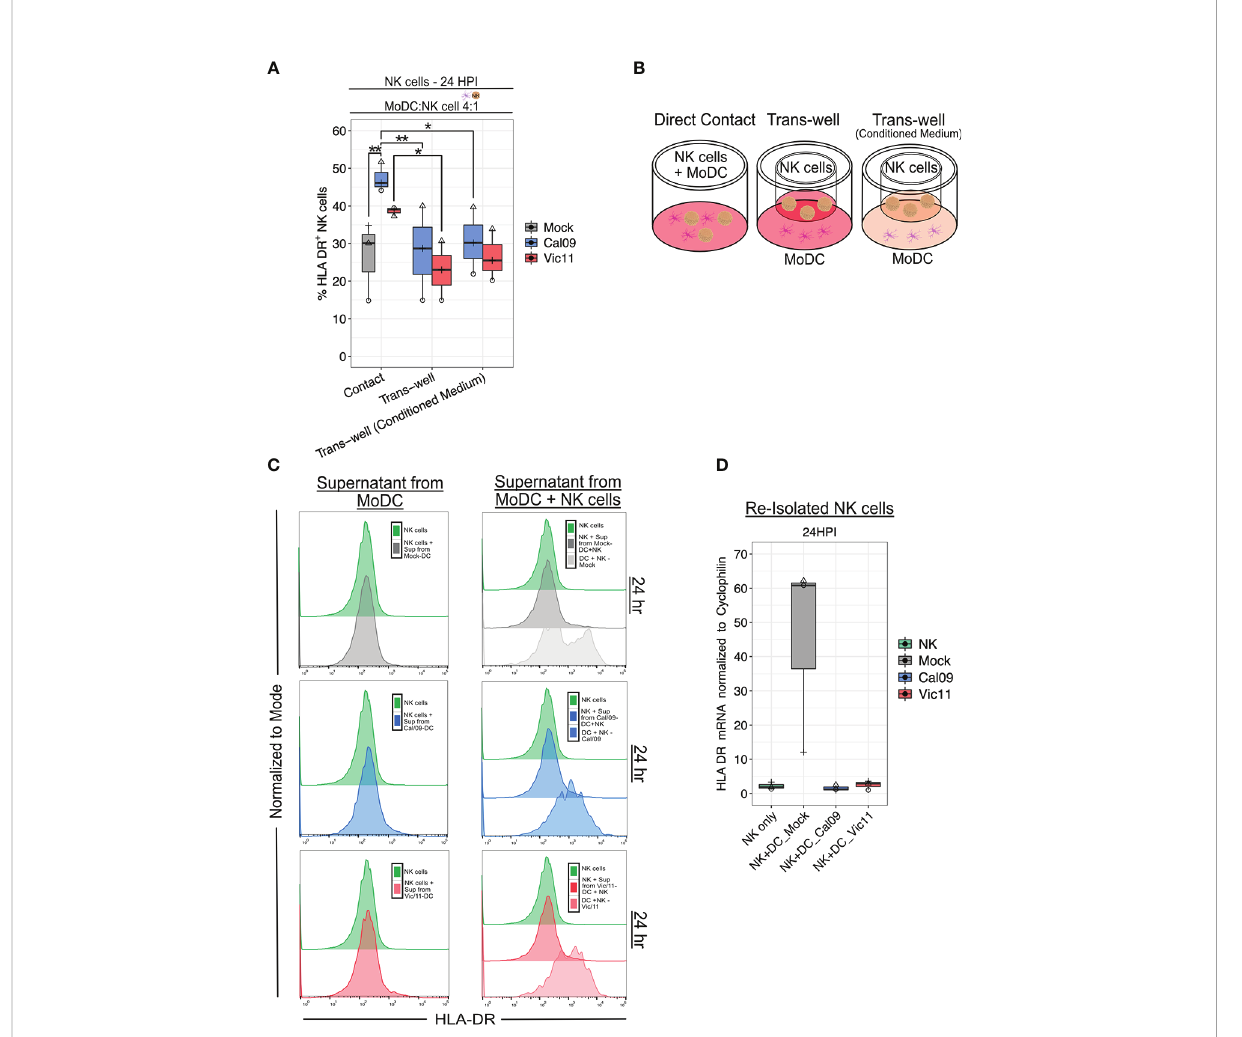
FIGURE 4 Direct contact is required for HLA-DR expression on NK cells after co-culture with IAV-exposed MoDCs. (A) Percentage of HLA-DR + NK cells and HLA-DR MdFI after 23 h co-culture with mock-treated or IAV-exposed MoDCs at an MOI of 3 as assessed by fl ow cytometry using an antibody speci fi c to HLA-DR. MoDCs were cultured in direct contact with NK cells (contact), with MoDCs seeded in the dish and NK cells seeded in the transwell with fresh medium (Trans-well) or with conditioned medium (Trans-well (conditioned medium) ( n = 3). (B) Schematic of experimental set-up shown in (A) . (C) Representative fl ow histograms of the percentage of the maximum count of HLA-DR on NK cells after exposure to supernatant from mock-treated (top), Cal/09- (middle), or Vic/11- (bottom) exposed MoDCs cultured alone (left panel) or with NK cells (right panel) at a MoDC to NK cell ratio of 4:1 ( n = 3). (D) Relative HLA-DR mRNA levels in NK cells re-puri fi ed after 23 h co-culture with mock-treated or IAV-exposed MoDCs when compared to NK cell control with RT-qPCR ( n = 3). The same shape between conditions indicates that the data point is derived from the same donor. * p < 0.05, ns p > 0.05. Two-way ANOVA, Prism